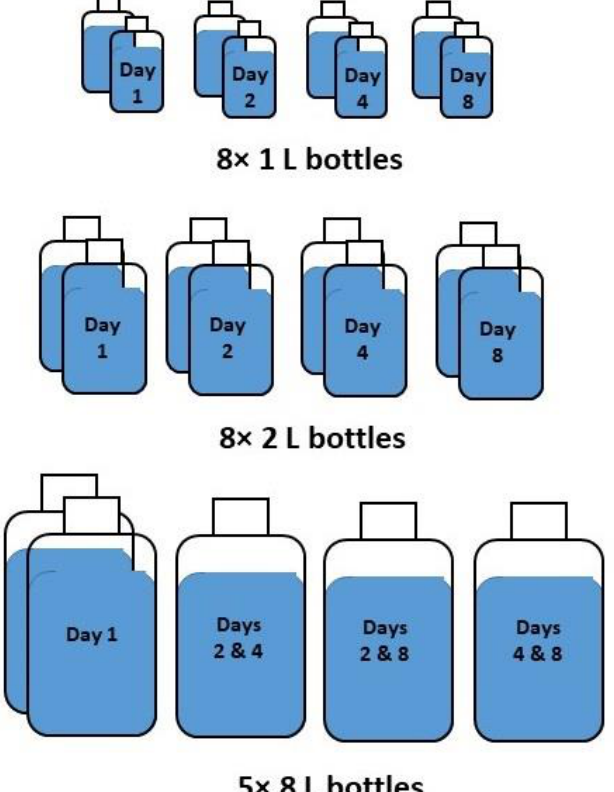
Figure 1. Experimental design, showing all bottles, corresponding volumes, and incubation periods for each